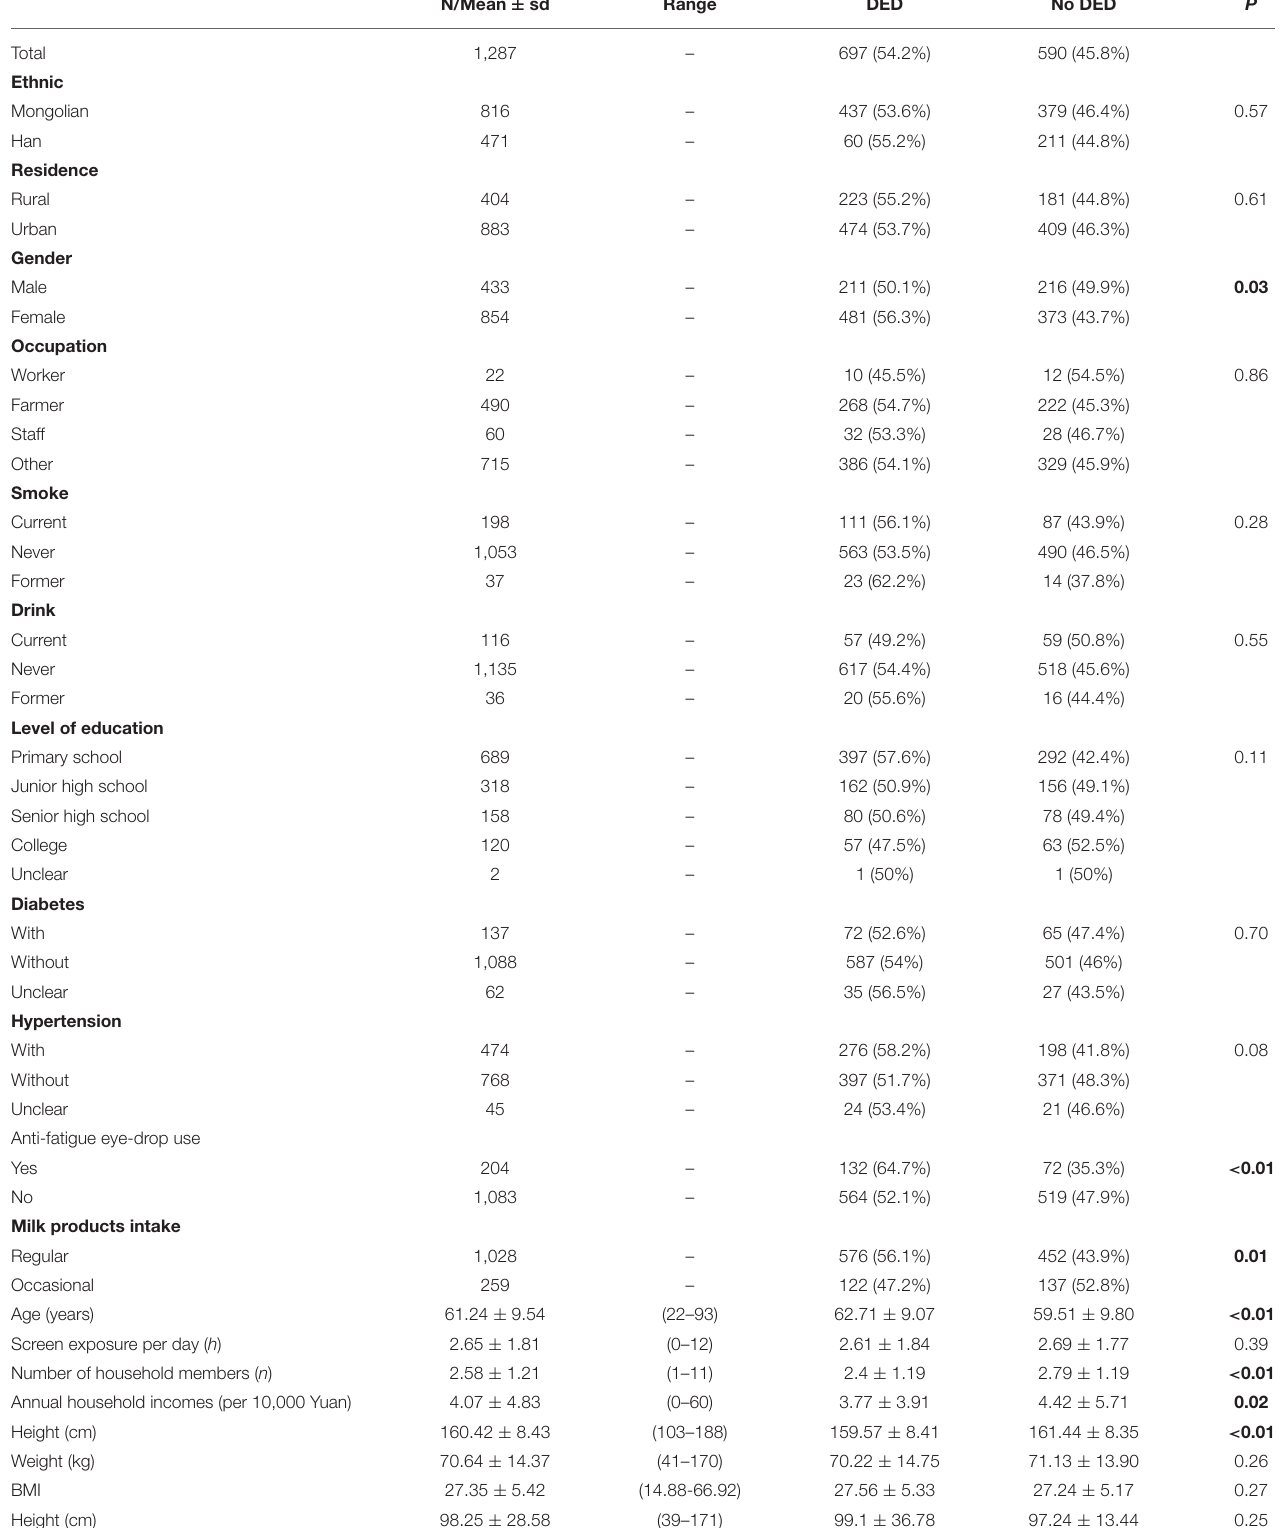
TABLE 1 | Characteristics of the